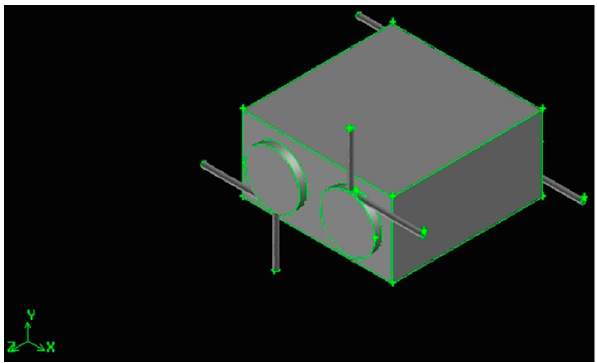
Figure 3. Swirling combustor converter, Z / D =